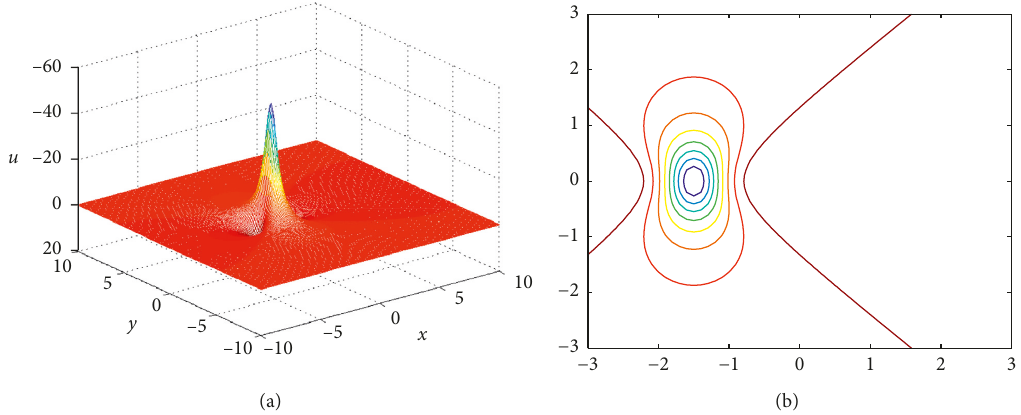
� 1 , α � 0 , α � 1 , α � 1 , α � 0 , α � 1 , α � 1 , α � 0 , α � 1 , and t � 1; (b) contour 2 4 6 7 8 9 10 12 13